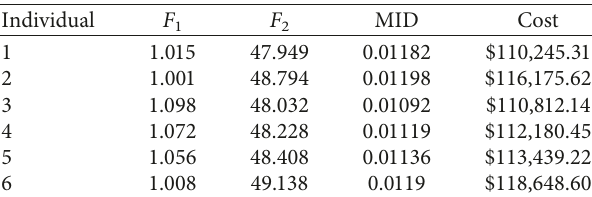
Table 3: Best individuals for model RC-3.